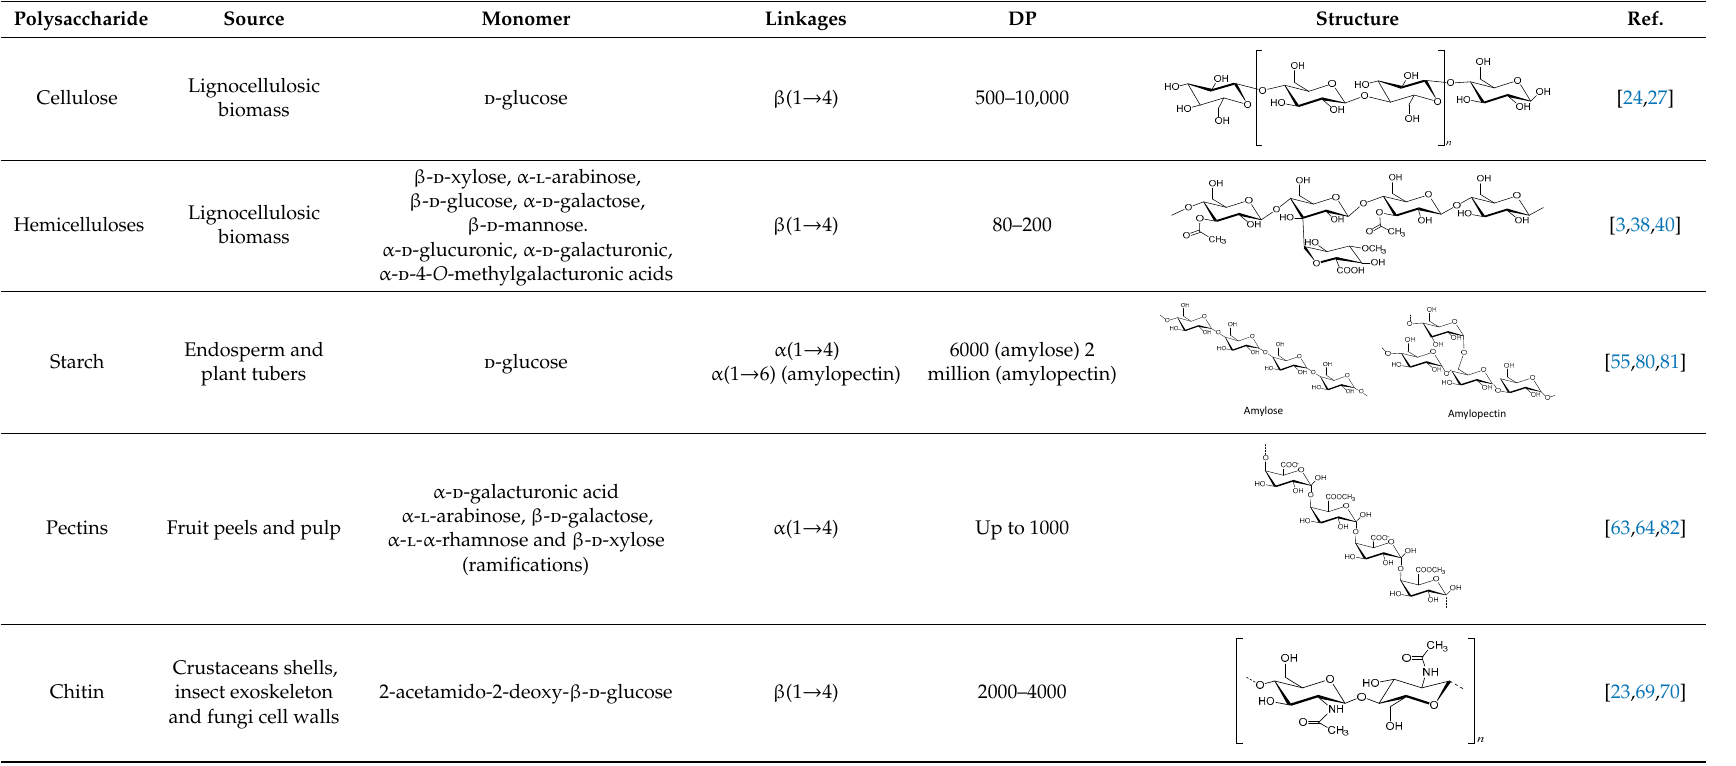
Table 1. Chemical and structural characteristics of polysaccharides mentioned in this work.